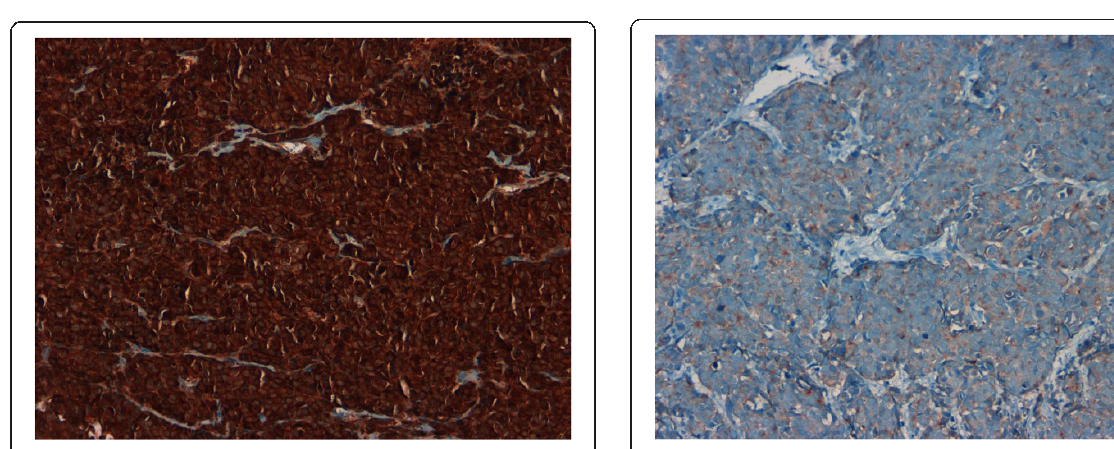
Figure 4 Tumor cells showed diffuse positivity for synaptophysin